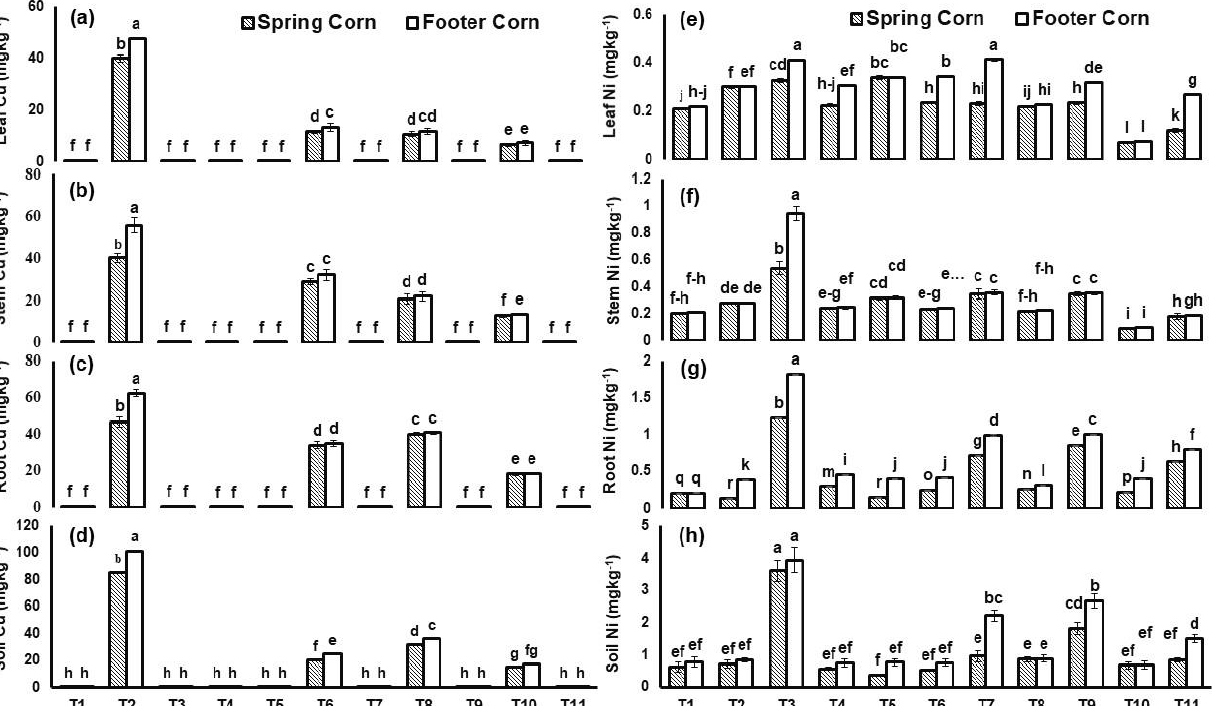
Figure 5. Concentration of total copper (Cu) in ( a ) leaf, ( b ) stem, ( c ) root, ( d ) soil and nickel (Ni) in ( e ) leaf, ( f ) stem, ( g ) root and ( h ) soil of Zea mays L. plants grown in heavy-metal-contaminated soil under different treatments such as T1 = Control; T2 = Cu(300 ppm); T3 = Ni(100 ppm); T4 = F2; T5 = BC(2%); T6 = F2 + Cu(300 ppm); T7= F2 + Ni(100 ppm); T8 = BC(2%) + Cu(300 ppm); T9 = BC(2%) + Ni(100 ppm); T10 = F2+ BC(2%) + Cu(300 ppm) and T11= F2+ BC(2%) + Ni(100 ppm). Values are the average of three replicates ± standard error (SE). Mean bars sharing similar lower-case alphabetic letters were non-significant ( p < 0.05) to each other while different letters represented significant difference declared by one-way ANOVA using LSD test at p ≤ 0.05.